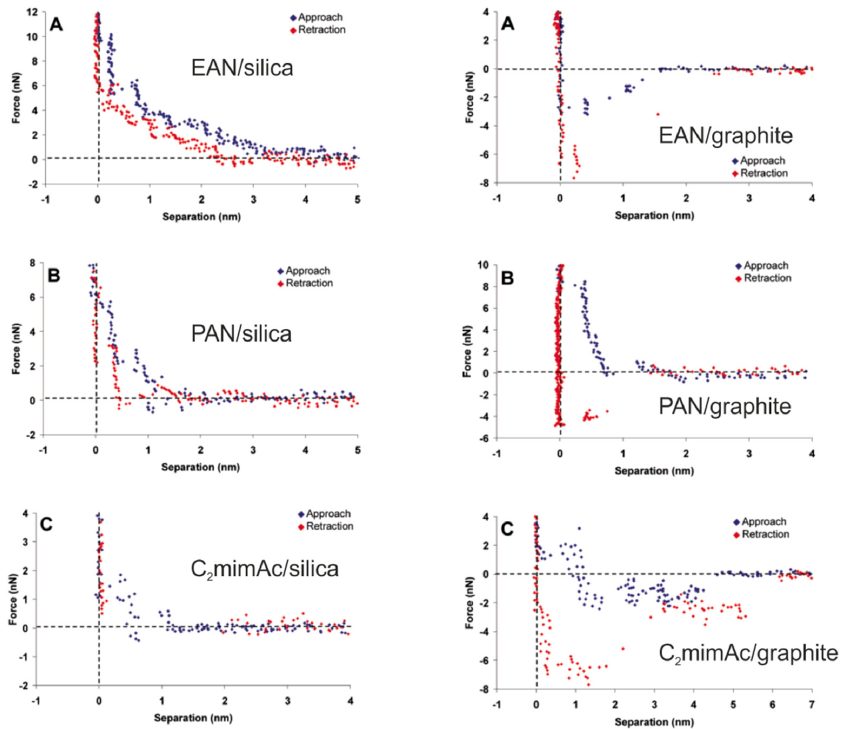
Figure 8. Force–separation curves measured on the silica surface (left) and the graphite surface (right) using three different ionic liquids, EAN (A), PAN (B) and C 2 MImAc (C). Adapted with permission from Atkin and Warr [88]. Copyright 2007, American Chemical Society.